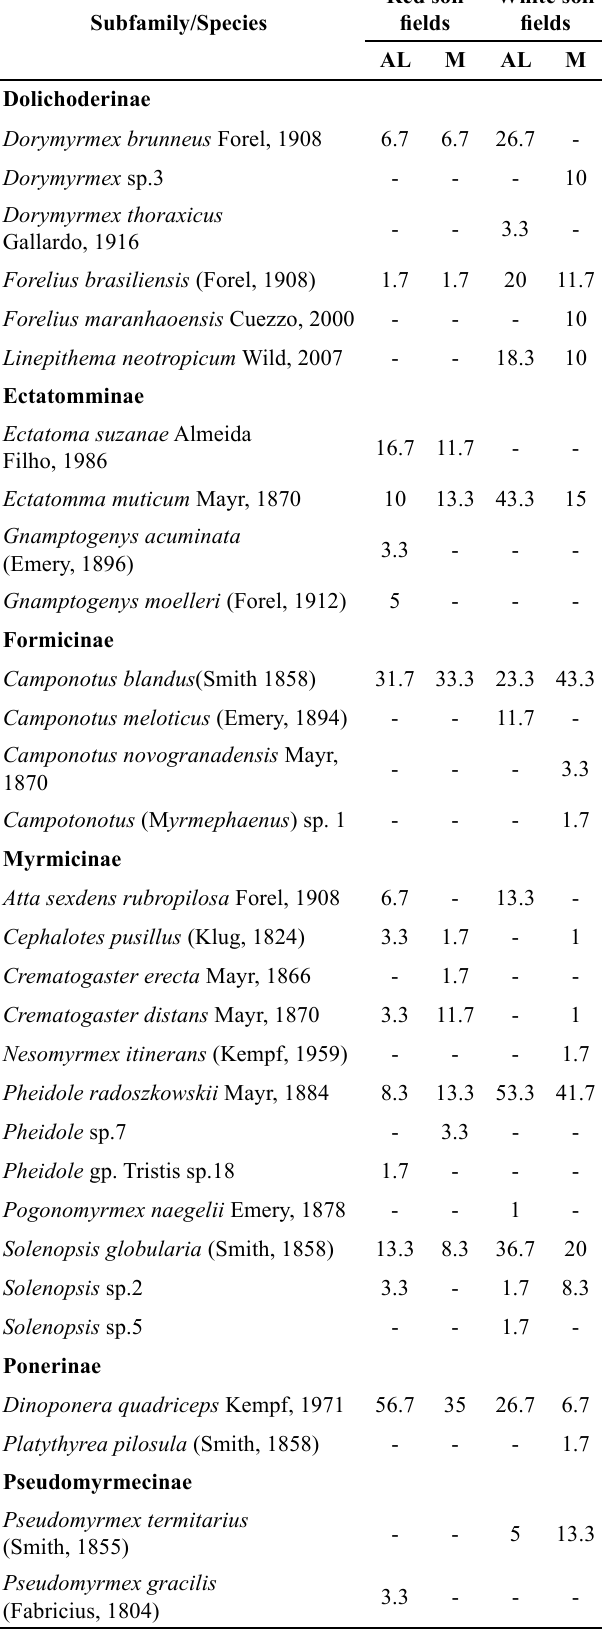
Table 3 . Frequency of occurrence (%) of ant species in mounds fields (2 fields in red soil and 2 fields in white soil) from Caatinga ecosystem, northeastern Brazil. (AL = adjacent lowland; M = mound).